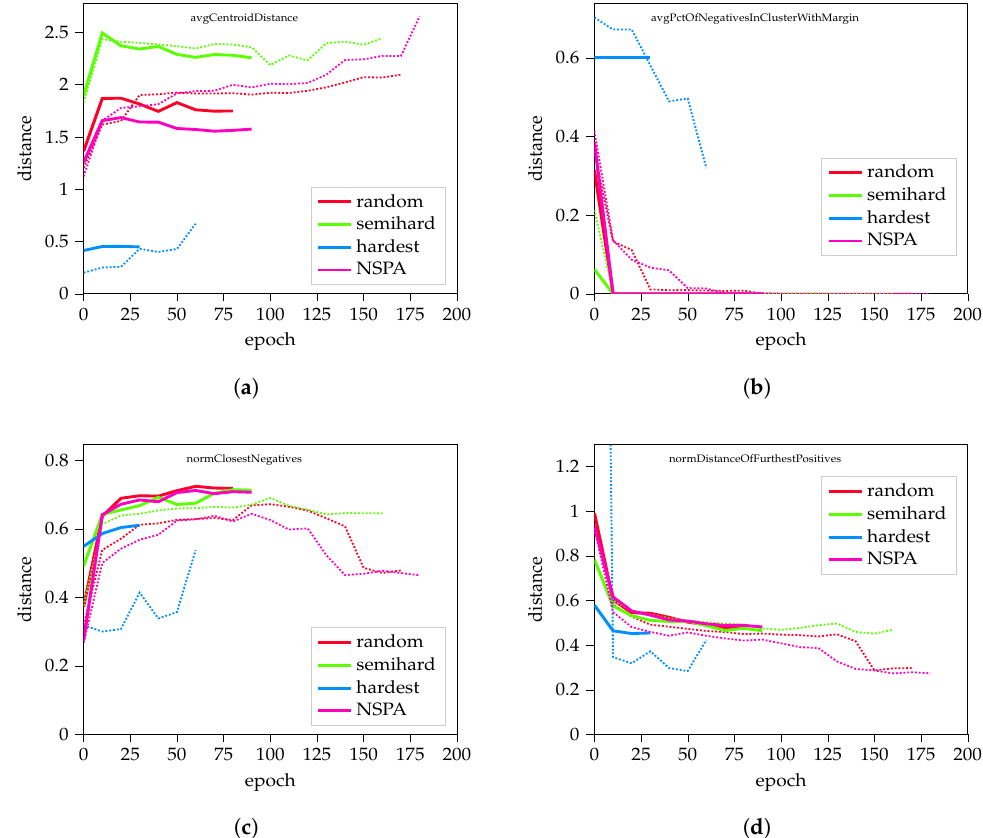
Figure 4. Results from applying the proposed NSPA method to synthetic data. ( a ) The average distance of cluster centroids; ( b ) the percent of different-class elements in the cluster; ( c , d ) display normalized results on the closest negative distance and the distance of the furthest positives, respec- tively. Dashed lines represent the mean values of different training experiments, while thick lines highlight representative records, which consist of average values including training length. Further results are available in the Appendix A, in Figure